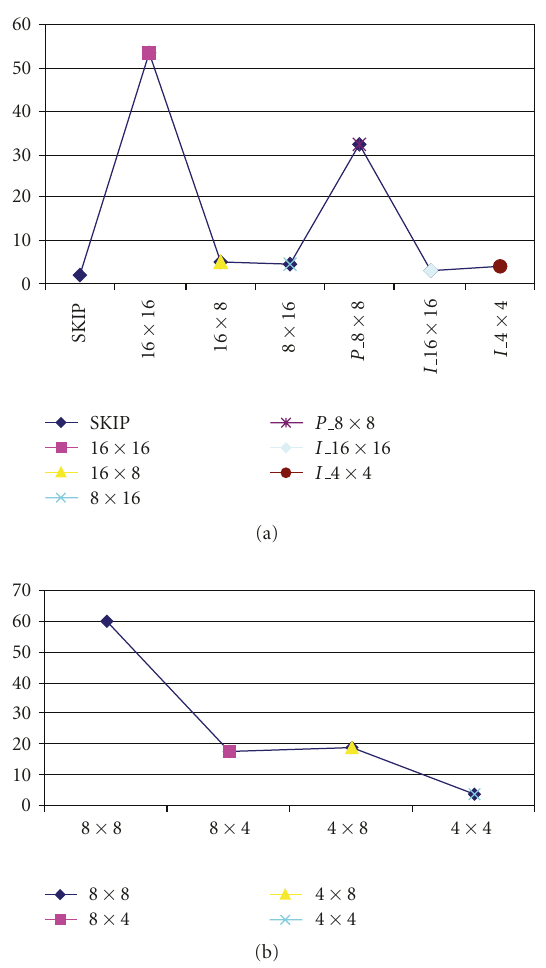
Figure 4: (a) Foreman. (b) Sub-MB of Foreman.